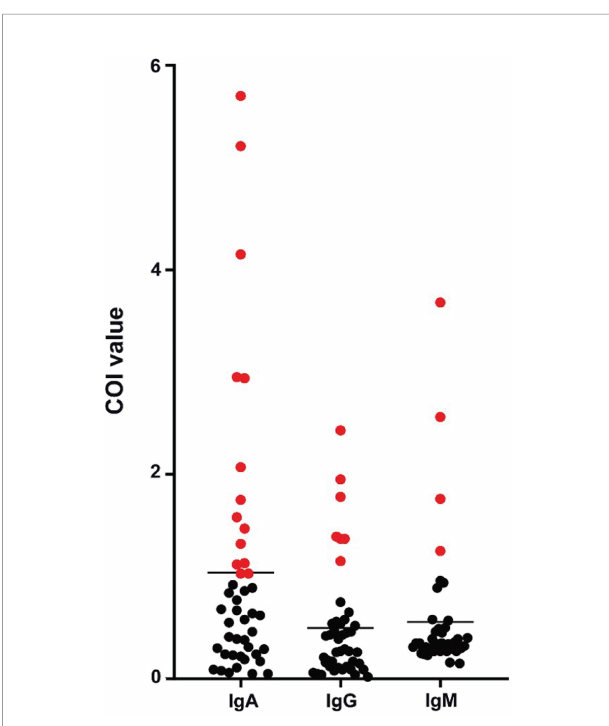
FIGURE 1 | Peak levels of saliva immunoglobulins in COVID-19 patients. Each point presented the highest measured COI value of immunoglobulin in saliva of each patient. Positive results were colored in red.